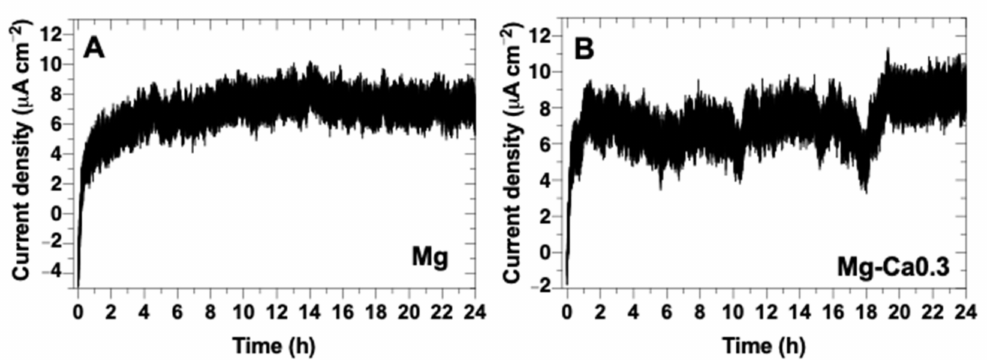
Figure 7. Corrosion current density fluctuations at OCP of ( A ) Mg and ( B ) Mg-Ca0.3 during 24 h of exposure to Hank’s solution.